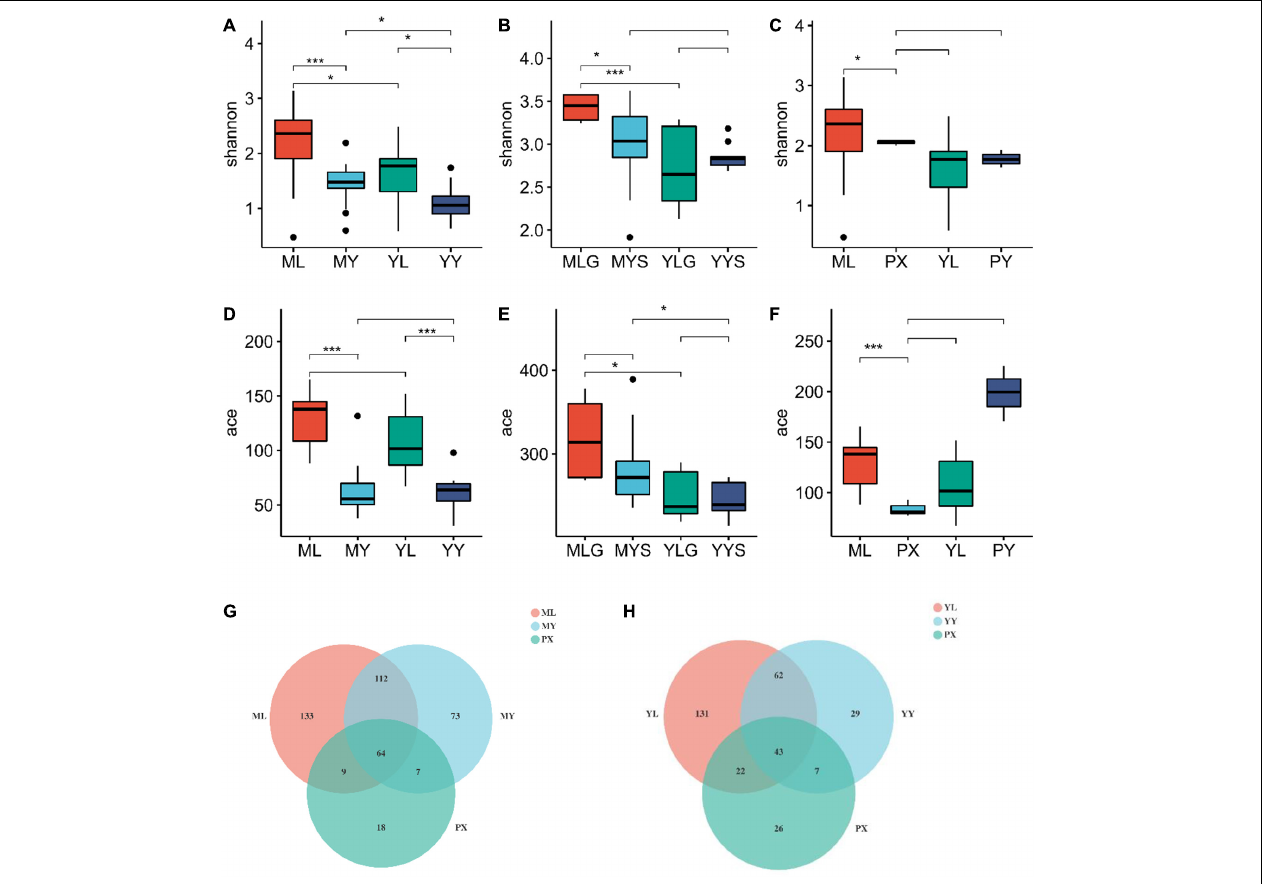
FIGURE 8 | (A–C) Shannon index diagram in the comparative breeding experiment; (D–F) ace index diagram of comparative breeding experiment between mountains and flat dam. (G) The venn diagram of endophytes under M-Y cultivation mode; (H) The venn diagram of rhizosphere fungi under Y-Y cultivation mode. ML refers to Lingzi under M-Y cultivation modes; YL refers to Lingzi under Y-Y cultivation modes; MY refers to Chuanxiong under M-Y cultivation modes; YY refers to Chuanxiong under Y-Y cultivation modes; MLS refers to the soil of Lingzi under M-Y cultivation modes; YLS refers to the soil of Lingzi under Y-Y cultivation modes; MYS refers to the soil of Chuanxiong under M-Y cultivation modes; YYS refers to the soil of Chuanxiong under Y-Y cultivation modes. PX refers to the Provenance of Lingzi Puxiong; PY refers to CX without transplantation. * is defined as significant, *** is defined as extremely